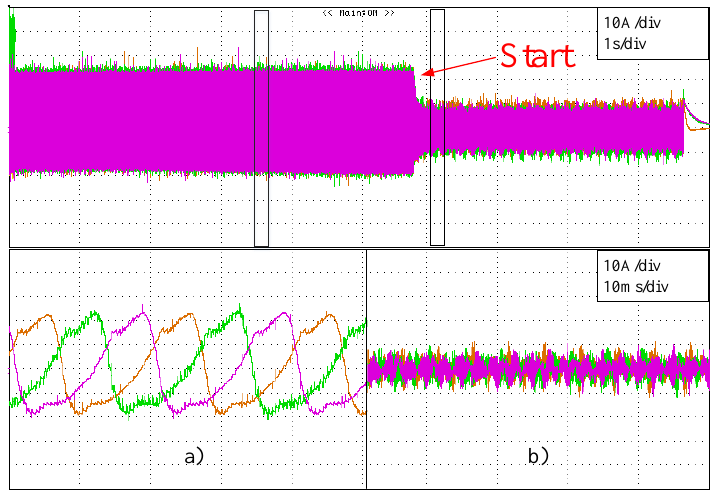
Figure 26. Circulating current comparison with repetitive controllers. ( a ) Before controller activation; ( b ) After controller activation.